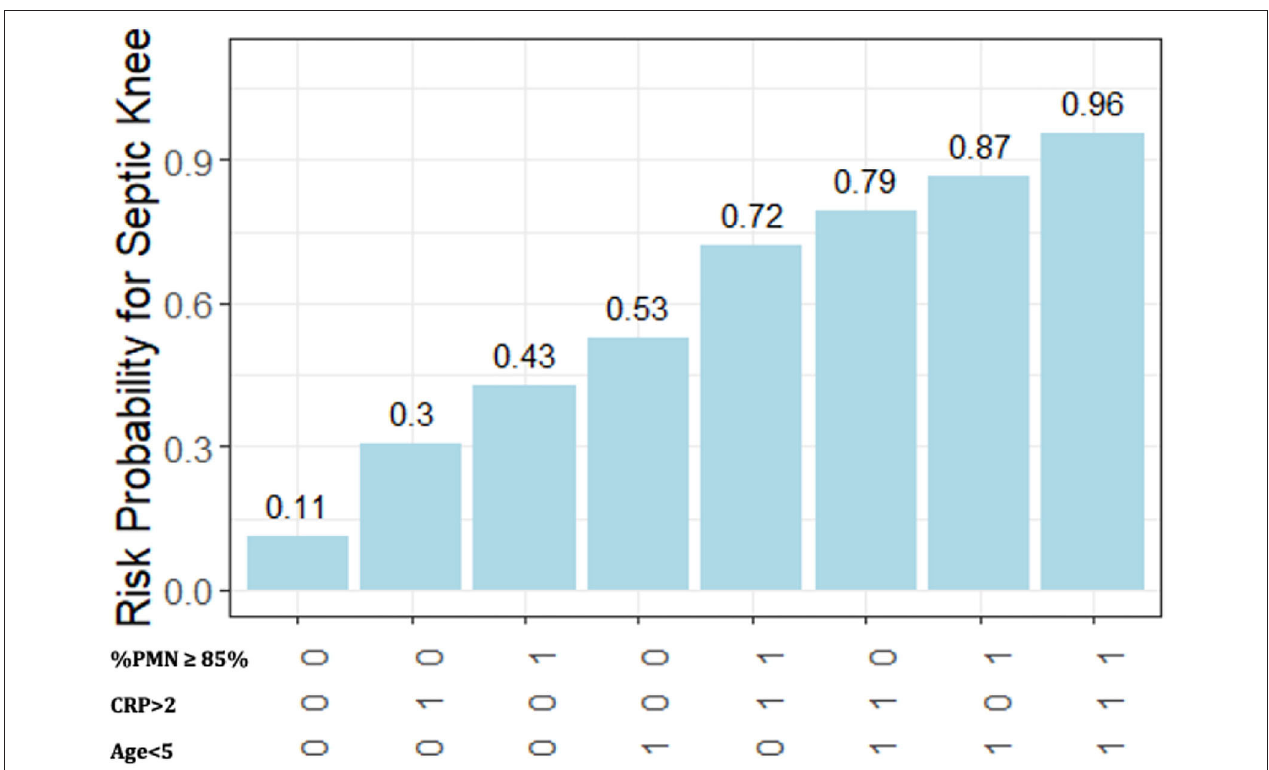
FIGURE 5 | Predicted probability for septic knee based on the predictor variable